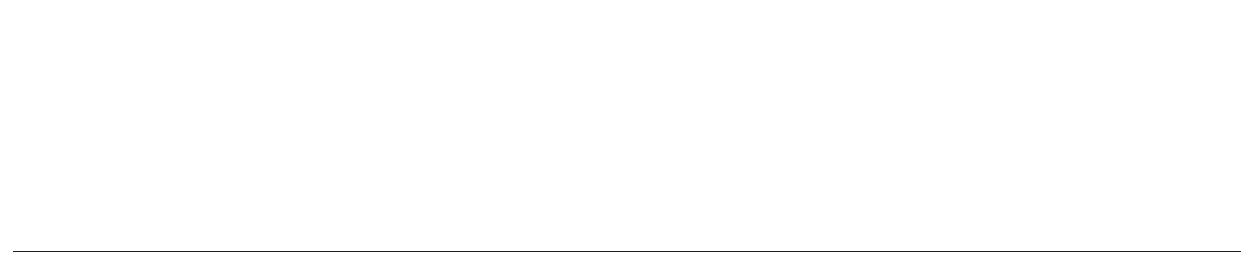
Frontiers in Microbiology | Antimicrobials, Resistance and